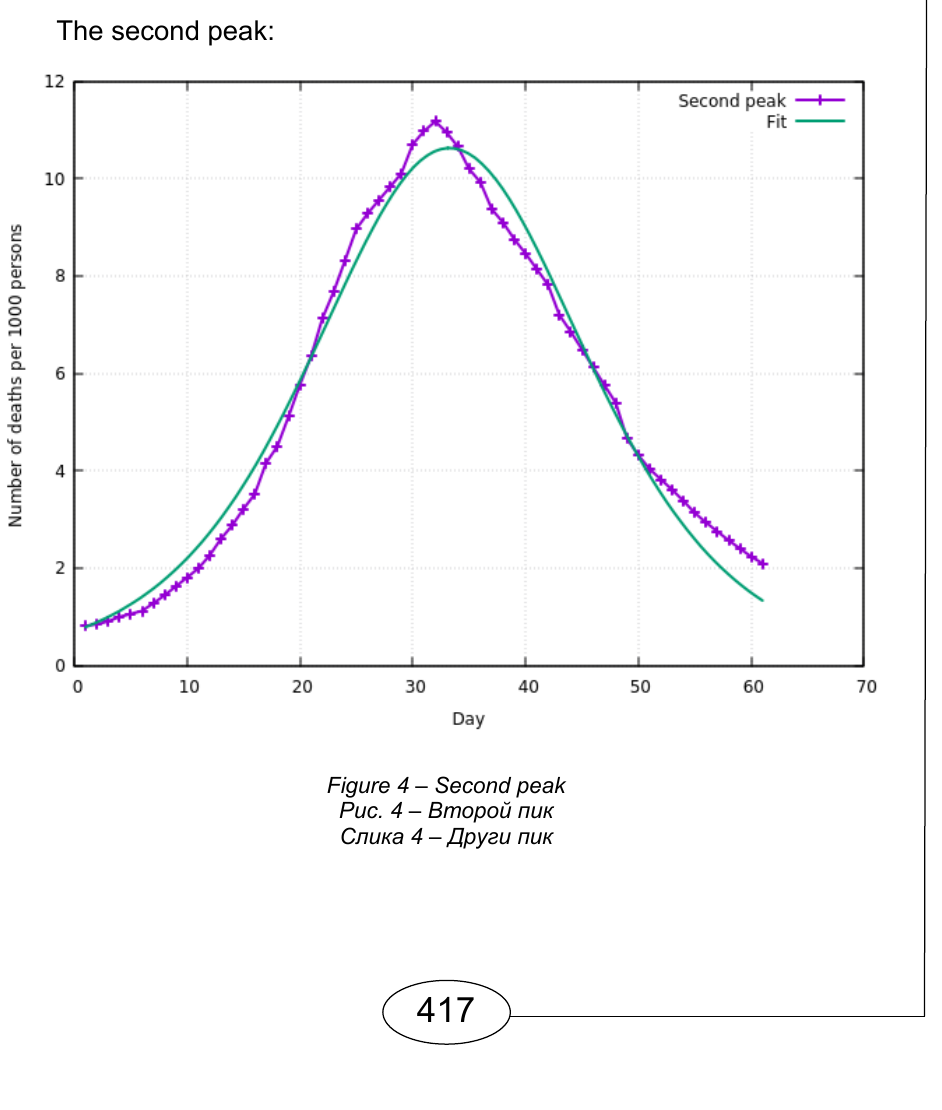
Figure 4 – Second peak Рис . 4 – Второй пик Слика 4 – Други